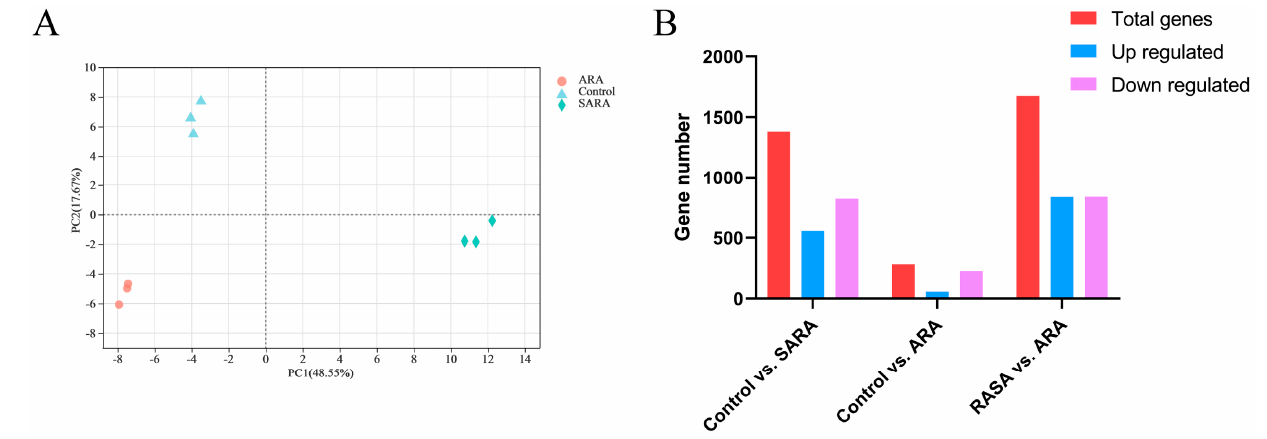
Figure 2. PCA of gene expressions and numbers of DEGs in the BRECs. ( A ). PCA of gene expressions in the three groups of BRECs. ( B ). Graphical representation of significant DEGs detected “control vs. SARA”, “control vs. ARA”, and “SARA vs. ARA” in BRECs cultured at different intensities at different pH values. Table 2. Number of DEGs discovered in three comparisons of BRECs after pH treatment. Total Groups Upregulated Downregulated Criteria Genes Control vs.